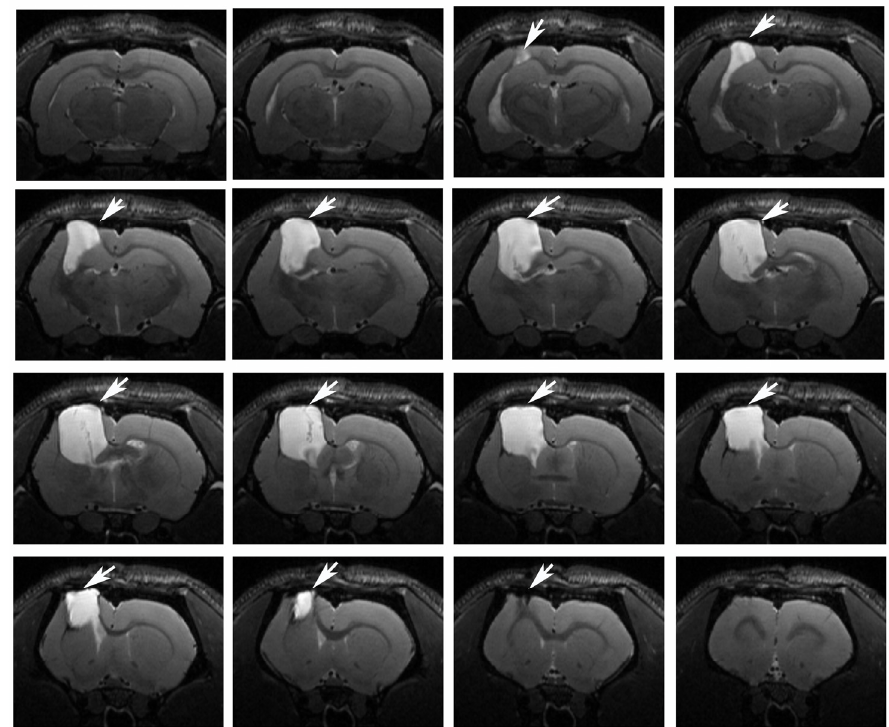
Figure 6. Magnetic resonance images of one experimental rat brain on the 180th day after traumatic brain injury. The left hemisphere, corpus callosum, cortex, and striatum are damaged (the damaged zone is indicated by an arrow).